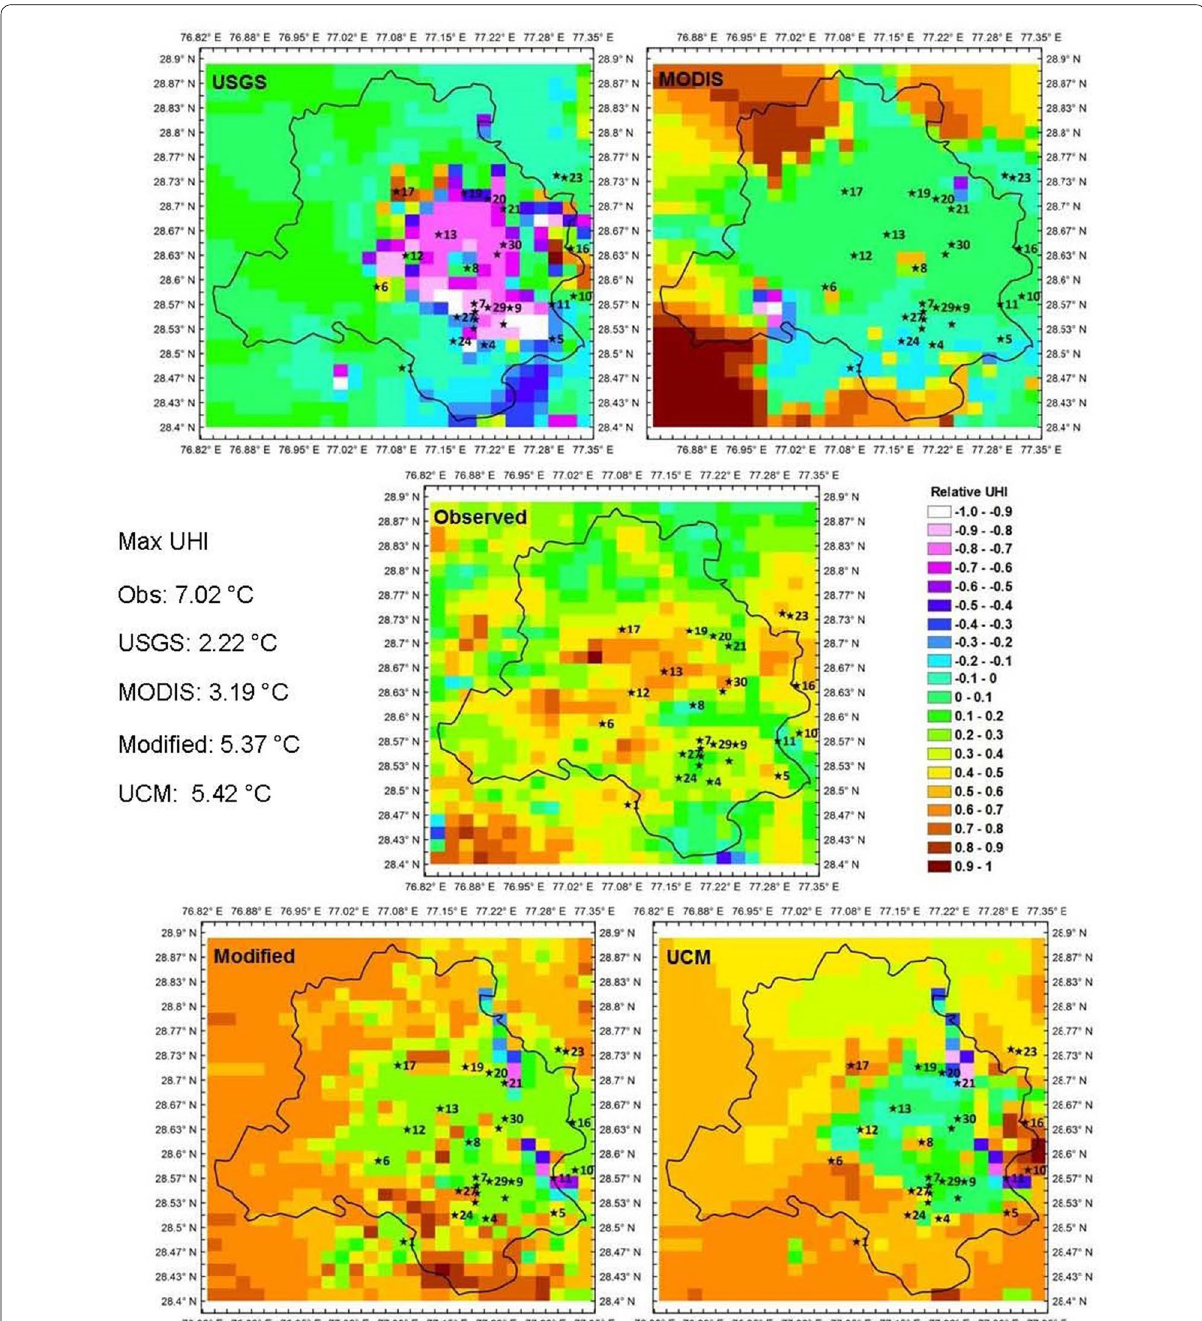
Fig. 11 Daytime distribution of relative surface heat island